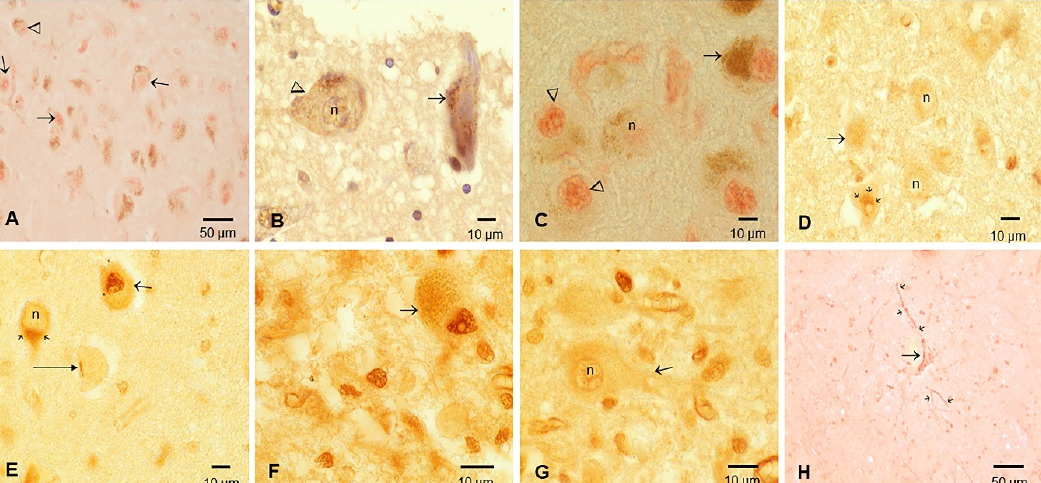
Figure 5. TDP-43 immunohistochemistry in locus coeruleus (LC), substantia nigrae (SN), pons and medulla. ( A ) Locus coeruleus in a 24 y old showing the spectrum of TDP-43 nuclear pathology from positive nuclear staining (short arrows) to negative nuclear IR (arrowhead). ( B ) Sixteen y old male with LC neurons showing negative nuclei and scanty dash-like IR (arrowhead), along with negative nuclear IR and prominent granular cytoplasmic IR (arrow). DAB, brown product. ( C ) 42 y old male SN neuron with IR negative nucleus (n) contrasting with IR-positive nuclei (arrowheads) with a few melanin granules and a neuron with abundant neuromelanin and IR-positive nucleus (arrow). Red product. ( D ) Cluster of pontine neurons in a 42 y old with IR-negative nuclei (n), fine granular cytoplasmic IR (arrow) and paranuclear strong IR (three arrows). DAB, brown product. ( E ) 42 y old male inferior olivary complex with unremarkable neurons (short arrow), nuclear IR negativity (n) and strong granular paranuclear IR (two short arrows). One neuron with a short tangle and a negative IR nucleus (long horizontal arrow) is also identified. ( F ) Seventy-five y old male area postrema with large neuron with strong nuclear IR (arrow). ( G ) Same subject as F with area postrema showing a large neuron (arrow) with nuclear (n) IR negativity. ( H ) Forty y old male medullary reticular neuron (long arrow) with nuclear IR negativity and extensive granular IR along axonal and dendritic tree (short arrows).